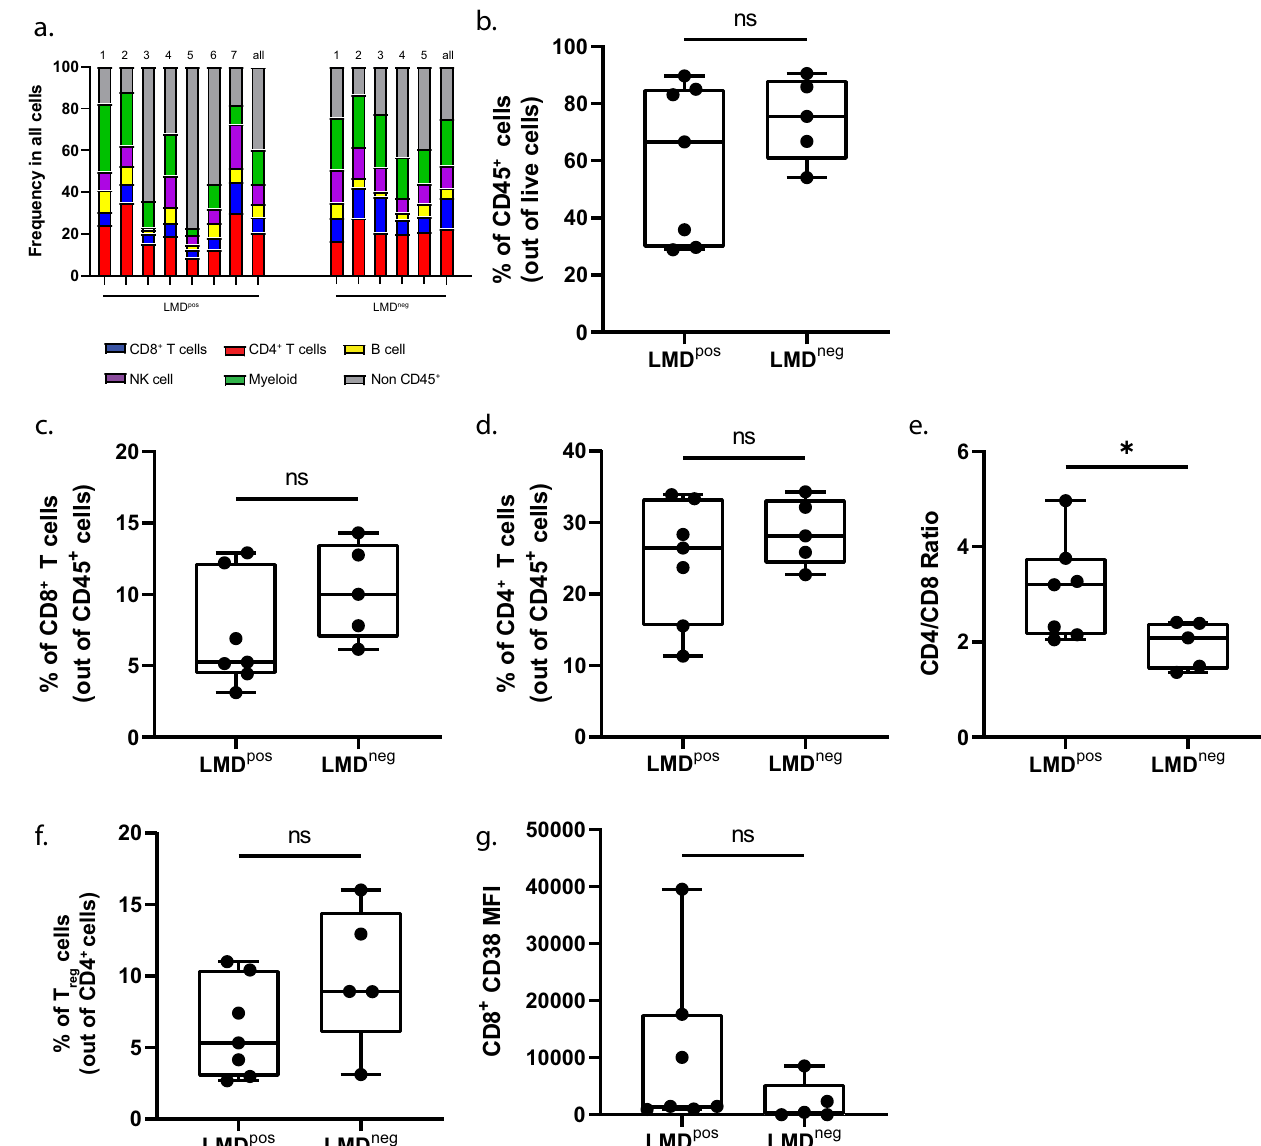
Fig. 4 Coarse changes in leukocyte populations in PBMCs are minimal. a Frequency plot in all cells of each individual patient and cumulative mean (all) comparing LMD pos (left columns) and LMD neg (right columns) in PBMCs. b – d Box plots comparing the frequency of immune cells between LMD pos vs. LMD neg by the following immune cell types: b CD45 + cells, c CD8 + T cells, d CD4 + T cells. e CD4/CD8 T cell ratios and f frequency of T reg . g Median fl uorescent intensity of CD38 expression on CD8 + T cells. For box plots in this fi gure, the boxes indicate the interquartile range, while the lower and upper bars correspond to the minimum and maximum non-outlier values of the data distribution. Centerline indicates the median value. The gating strategy for this fi gure is derived from Fig. 2a. Statistical signi fi cance was assessed in b – g by unpaired student t -test. (*) indicates statistical signi fi cance with p < 0.05, p < 0.01 respectively. n.s not signi fi